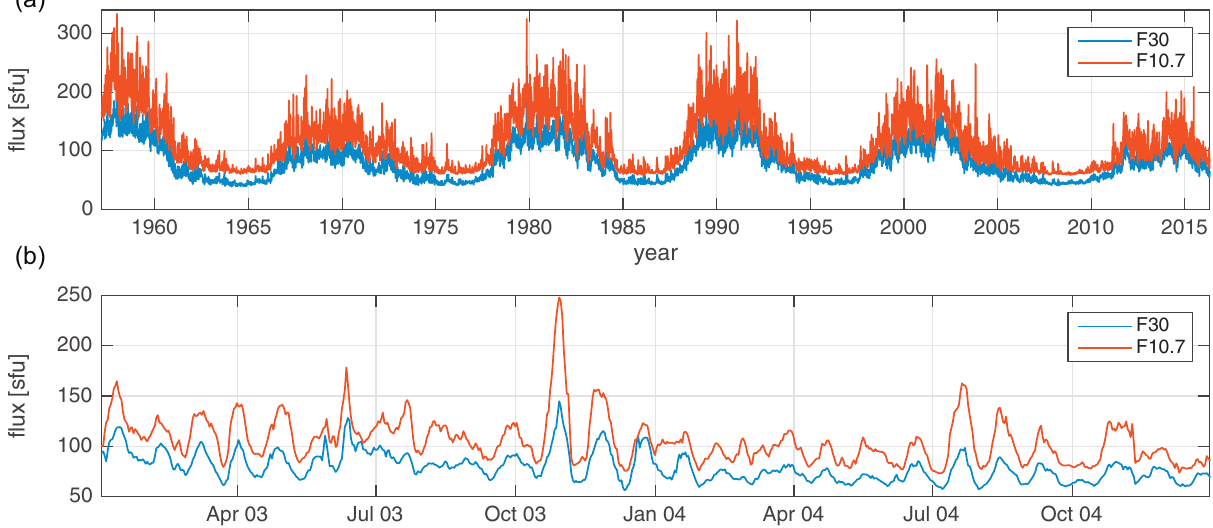
Fig. 1. Original values of F30 and F10.7 since 1 March 1957, when the F30 series starts. (a) Full record, and (b) a two-year excerpt with the Halloween event of October 2003.